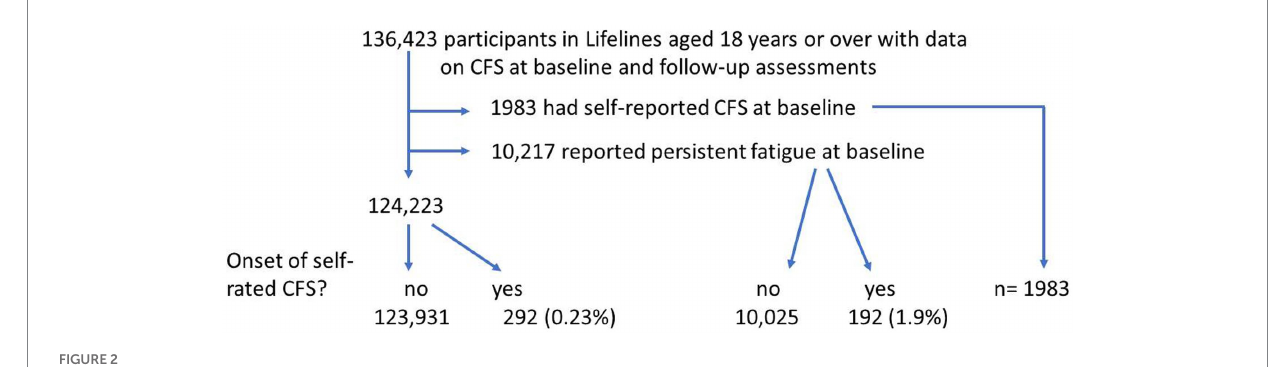
FIGURE 2 Flowchart of participants—chronic fatigue syndrome.